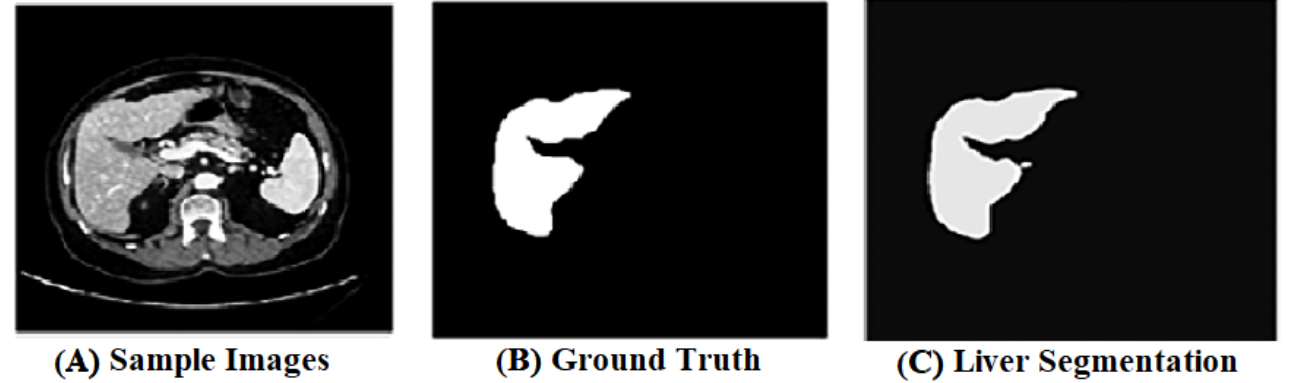
Figure 4. Sample Output for liver segmentation. ( A ) Sample image; ( B ) Ground Truth; ( C ) Liver Segmentation.